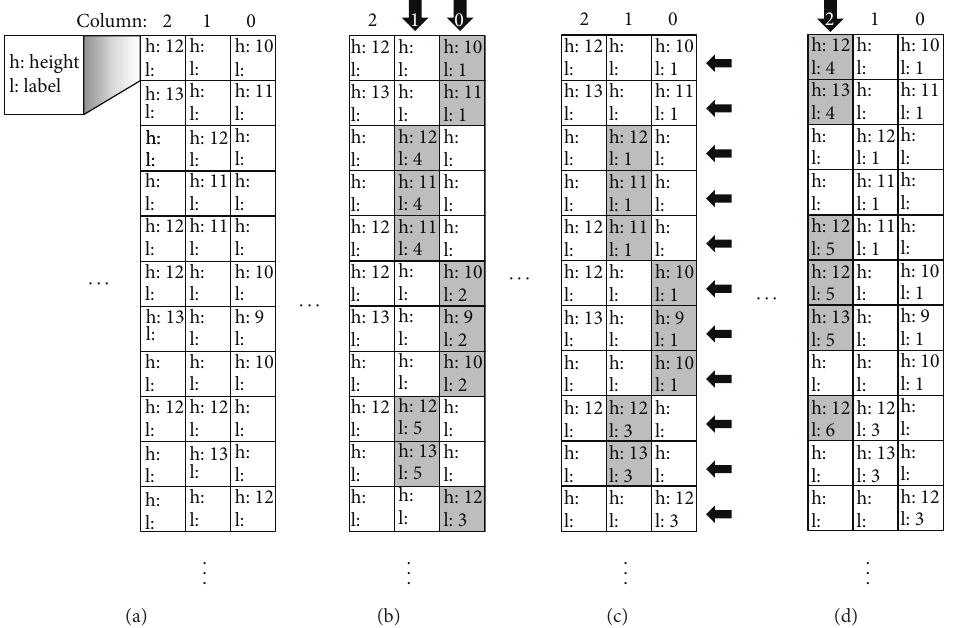
Figure 3: Voxel labeling in lowermost heightmap. Each square represents a voxel, which has height and label attributes. (a) Initial state of lowermost heightmap before executing voxel labeling. (b) Execute VerticalLabeling for 0th and 1st columns independently. (c) Execute HorizonalLabeling for the two columns. (d) After executing VerticalLabeling for 2nd column, execute (c) for 1st and 2nd columns.